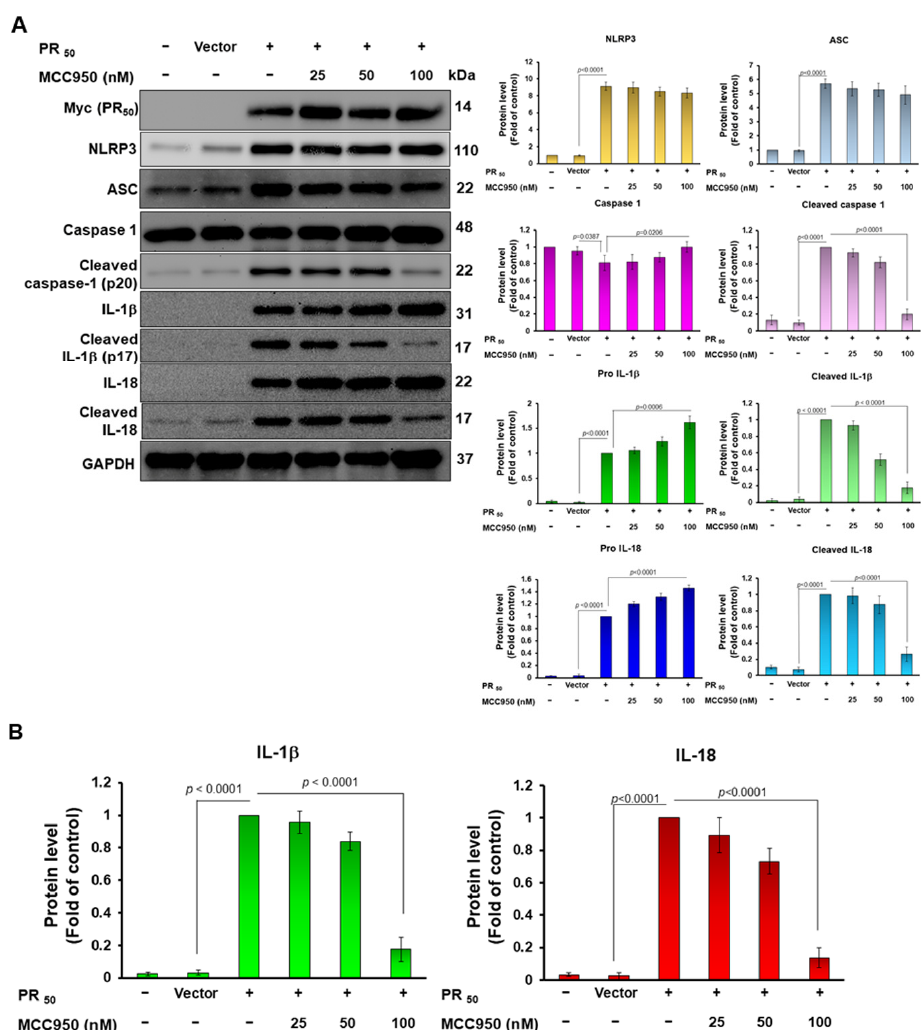
Figure 3. MCC950 inhibited NLRP3 inflammasome activity in PR 50 -expressing HMC3 microglial cells. PR 50 -expressing HMC3 cells were treated with 0, 25, 50, or 100 nM MCC950 for 24 h. ( A ) Cell lysates were analyzed for the expression of PR 50 (Myc), NLRP3, ASC, pro caspase-1, cleaved caspase- 1 (p20), pro IL-1 β , cleaved IL-1 β (p17), pro IL-18, and cleaved IL-18 by Western blotting. GAPDH was used as an internal loading control. The left panel shows a representative set of images, and the right panel shows quantitative analysis graphs using ImageJ software. ( B ) The level of mature IL- 1 β and mature IL-18 in the conditional medium were measured by ELISA.